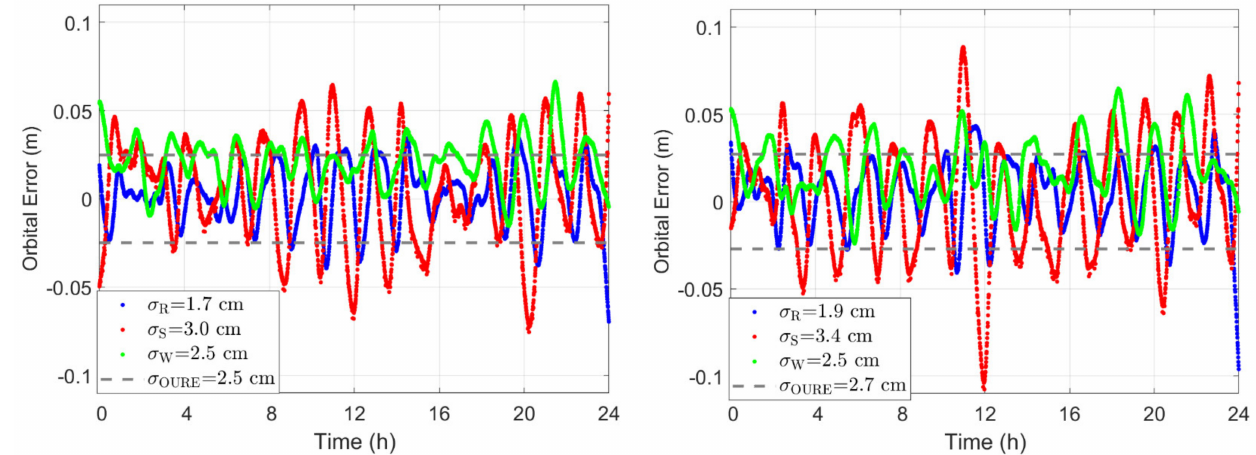
Figure 3. Near-real-time BLS orbital errors of Sentinel-3B on 15 August 2018 using ( left ) the CNES real-time products and ( right ) the IGS RTS